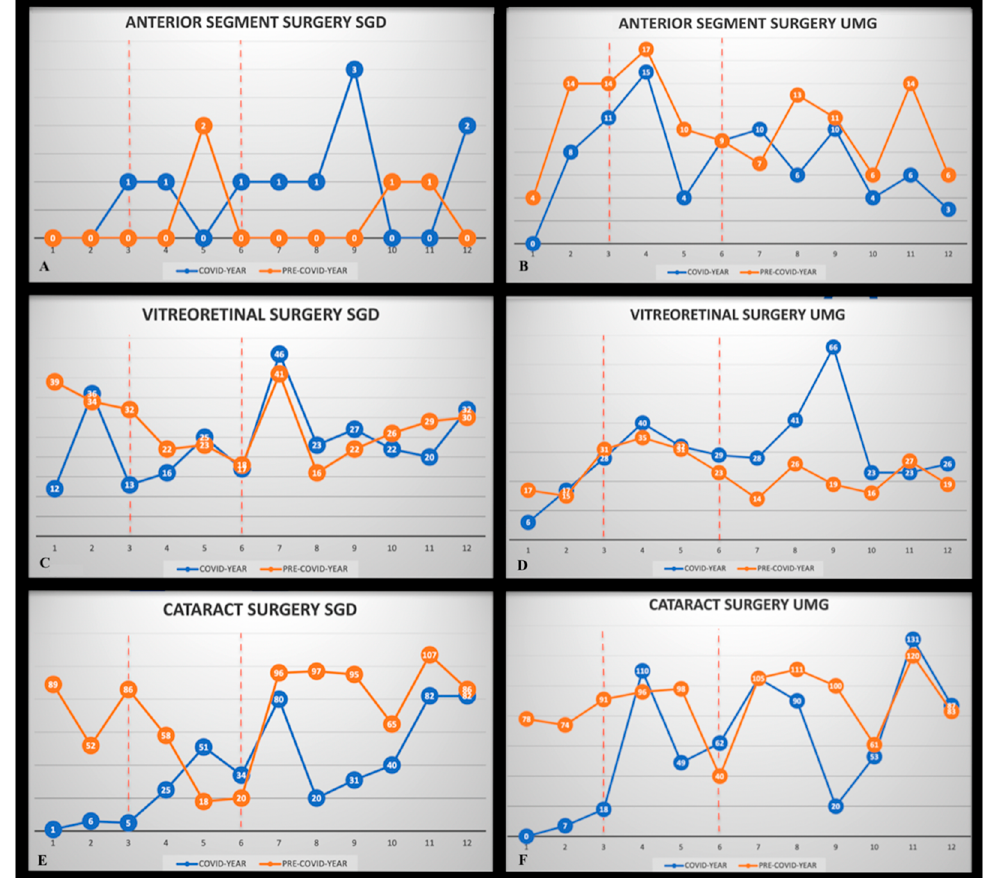
Figure 3. The monthly number of surgical procedures performed during the COVID-19-year (blue) compared with pre-COVID-19 year (orange) for the different categories: ( A ) corneal surgery performed at San Giovanni di Dio (SGD); ( B ) corneal surgery performed at University Magna Græcia of Catanzaro (UMG); ( C ) vitreoretinal surgery performed at SGD; ( D ) vitreoretinal surgery performed at (UMG); ( E ) cataract surgery performed at SGD; ( F ) cataract surgery performed at UMG. The dotted orange line in each figure divided the period studied into three phases: lockdown, unlock, and second wave, from left to right,